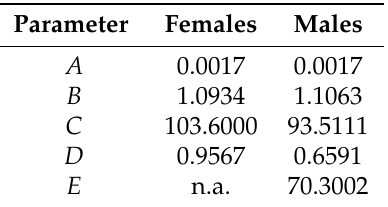
Table 3. Parameters of the Rickayzen–Walsh